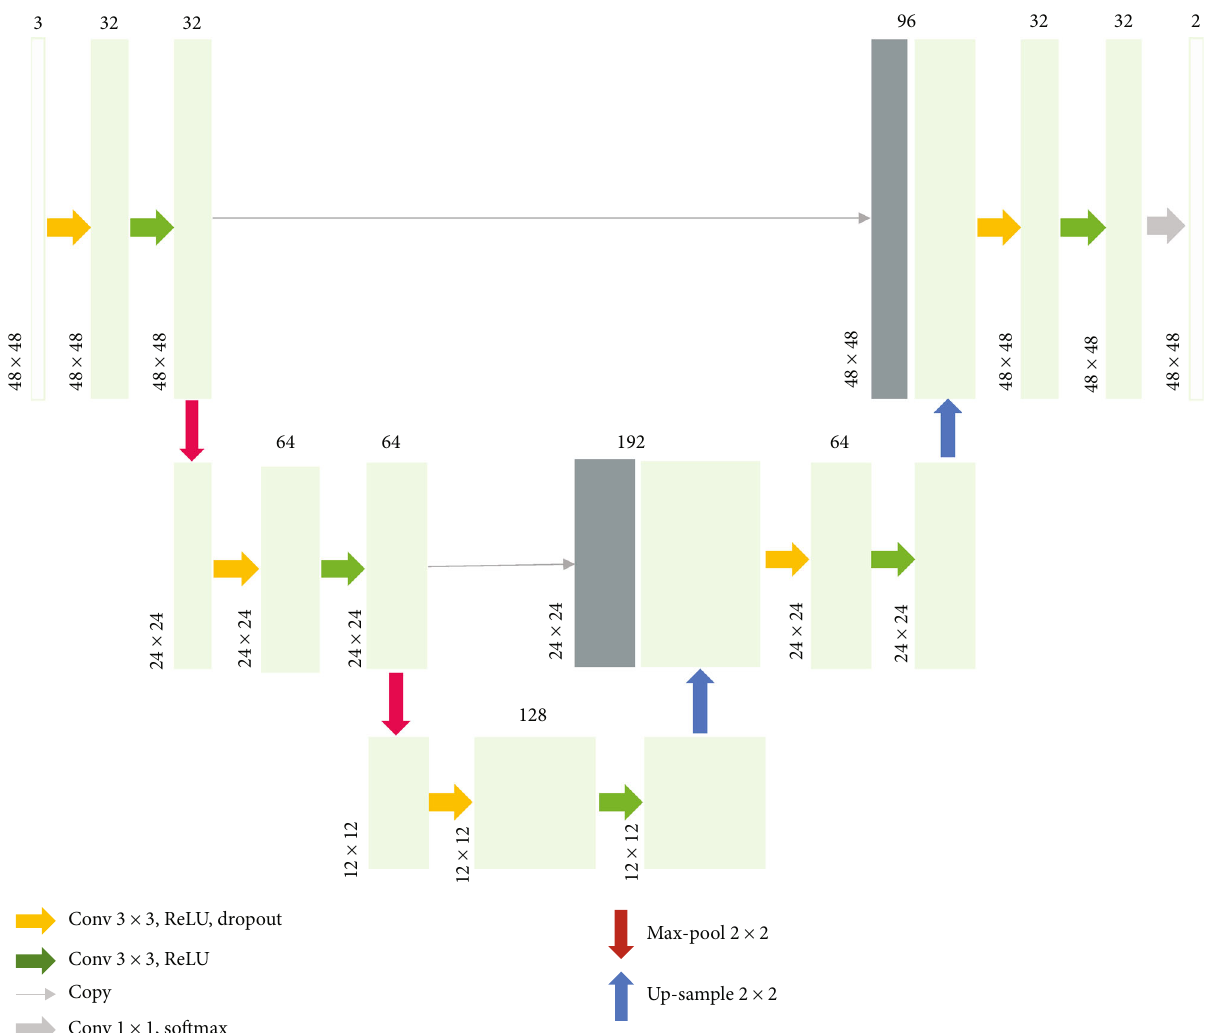
Figure 2: The lightweight U-Net architecture. Each green box corresponded to a multichannel feature map. The number of channels was denoted on top of the boxes. The x - y size was provided at the lower left edge of the box. Gray boxes represented copied feature maps. The arrows denoted the di ff erent